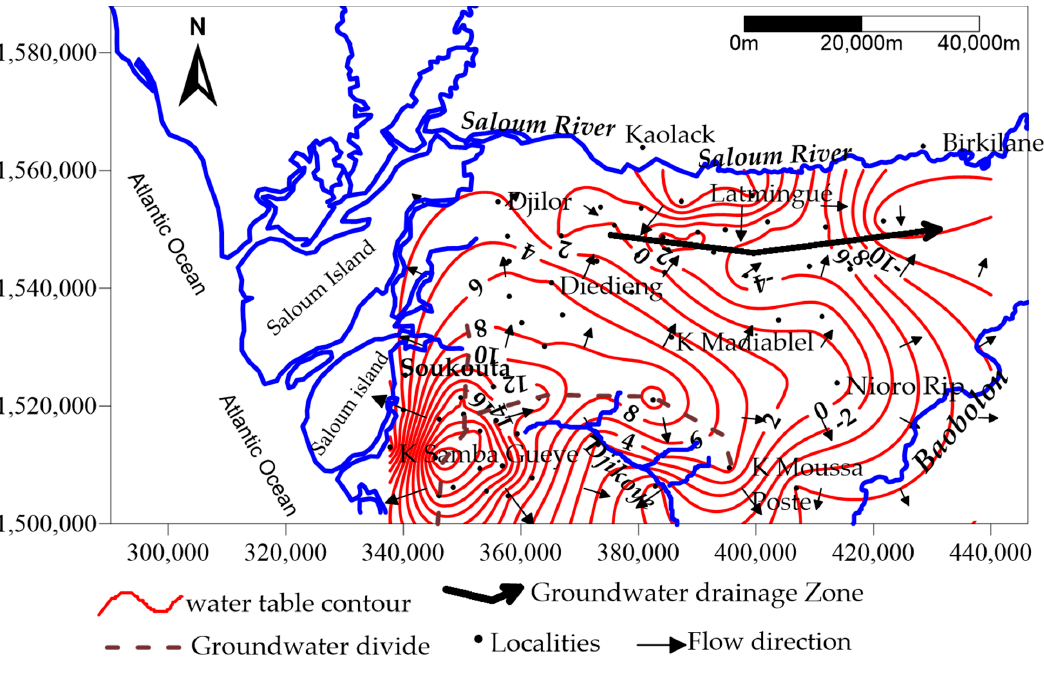
Figure 3. Piezometric map (May 2012).